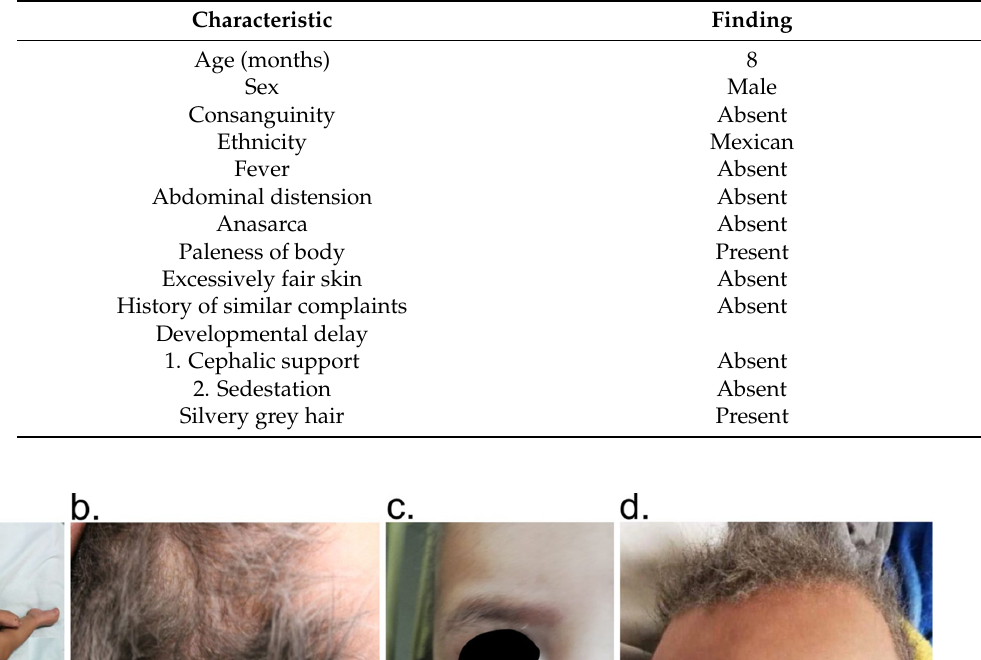
Table 1. General characteristics of the patient.